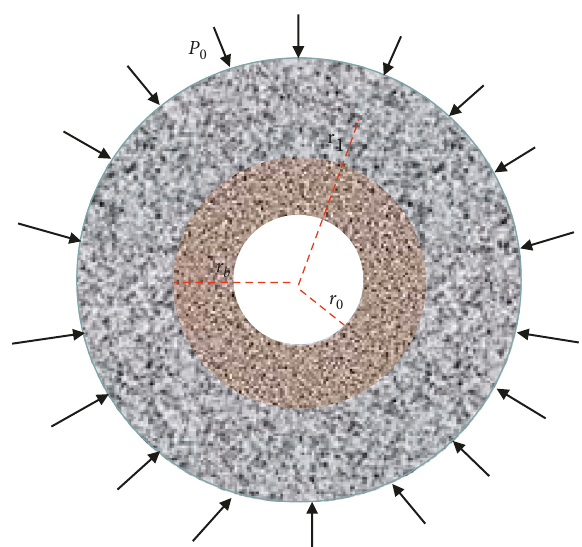
Figure 4: Mechanical model after tunnel blasting surrounding rock modification.